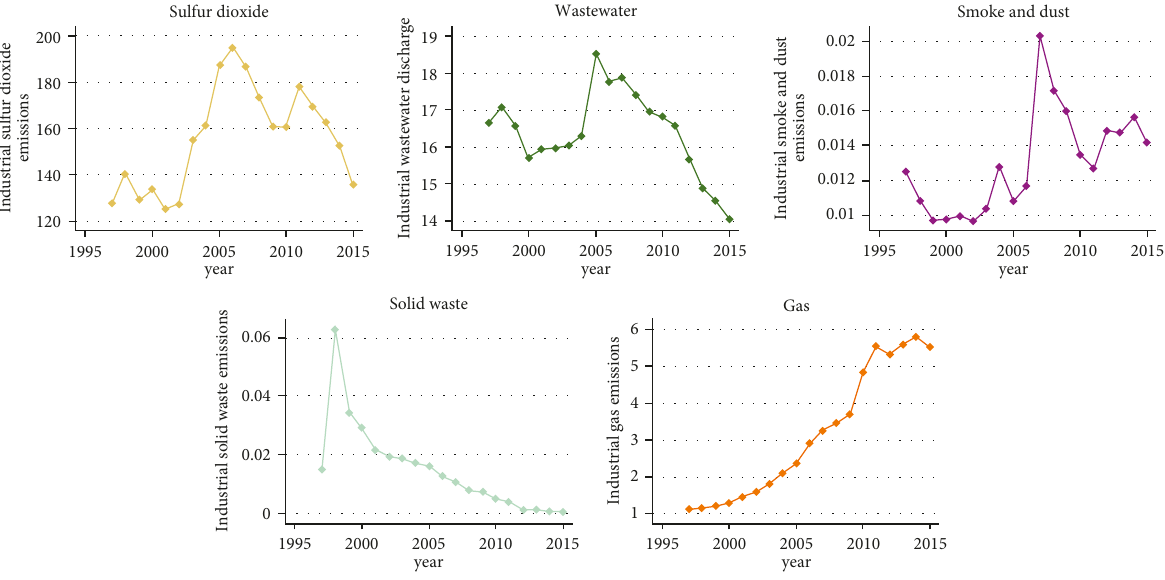
Figure 1: Industrial pollutant emissions from 197 to 2015 in China.